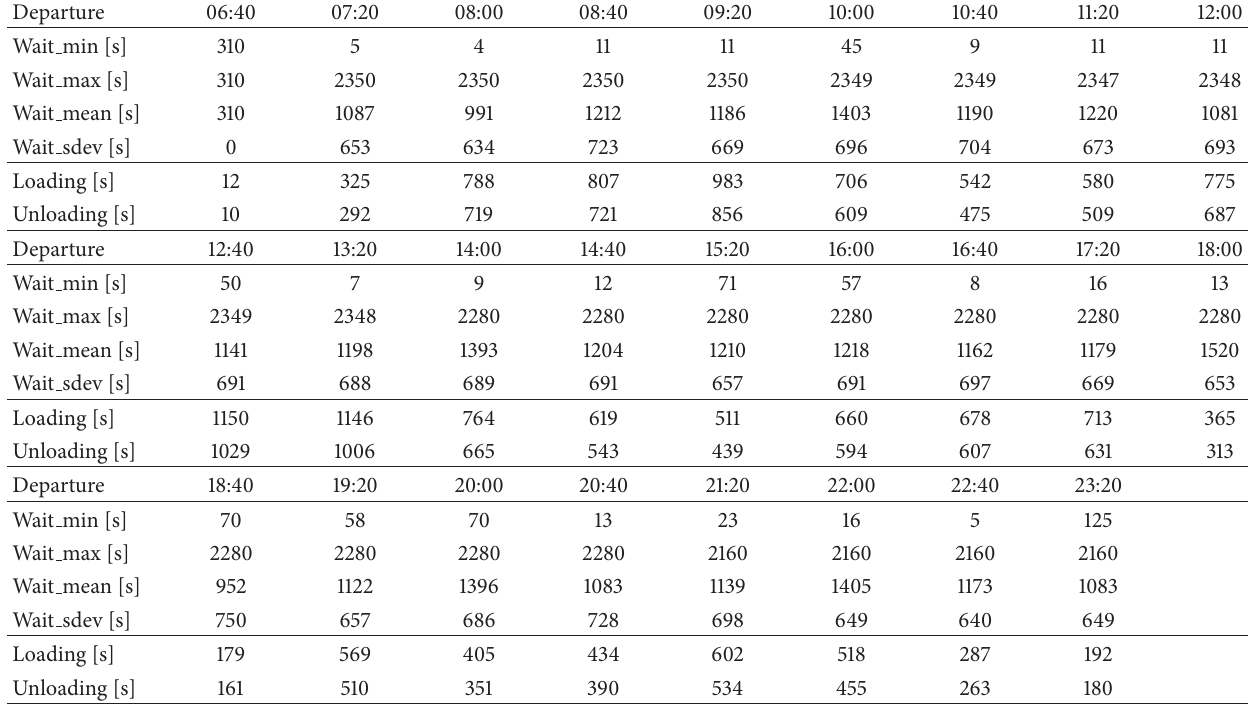
Table 6: Waiting times for loading/unloading operations, first simulation.